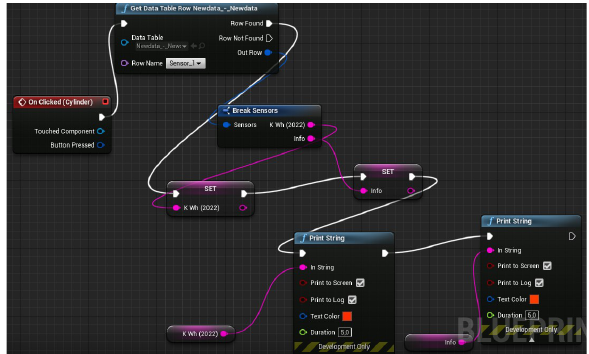
Figure 9. The Event Graph of Blueprint nodes for sensors